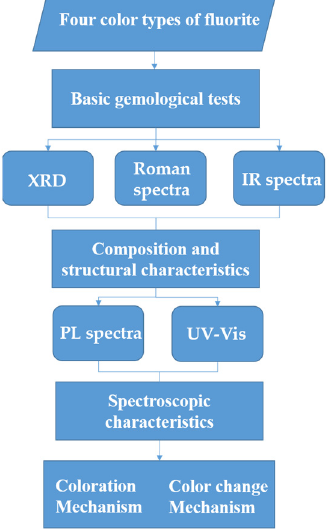
Figure 2. Experiment flow chart.